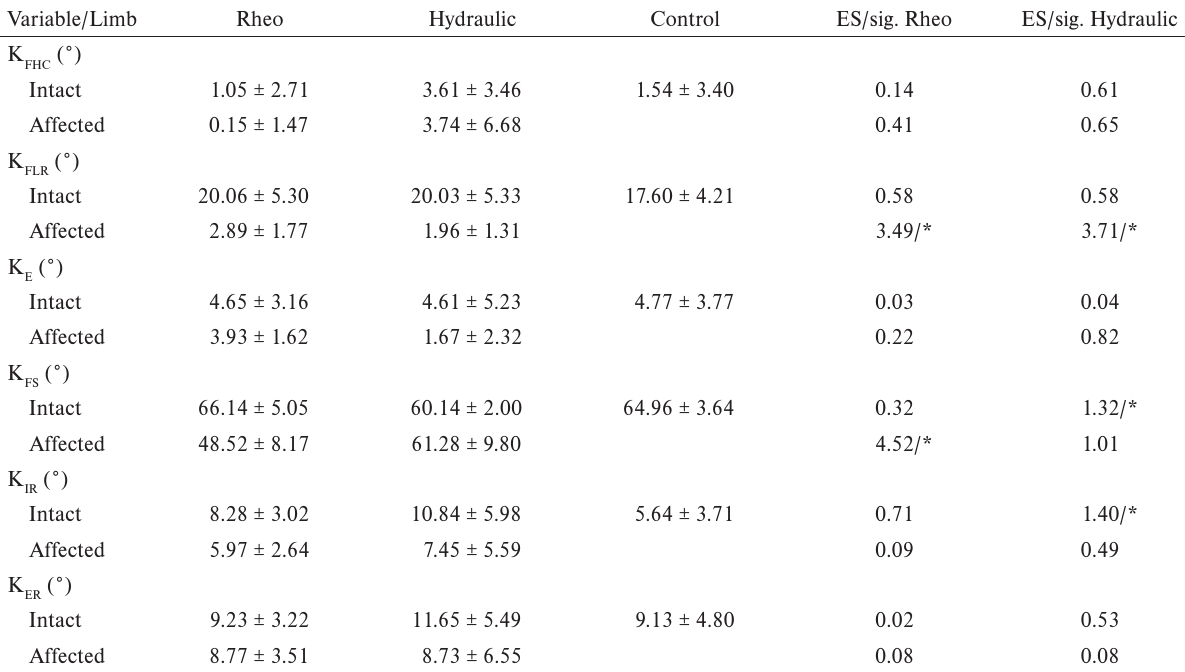
Comparison of angle parameters in the knee joint during gait of patients with bionic knee joints (Rheo), patients with hydraulic knee joints (Hydraulic) and the control group (Control) Variable/Limb Rheo Hydraulic Control ES/sig. Rheo ES/sig. Hydraulic